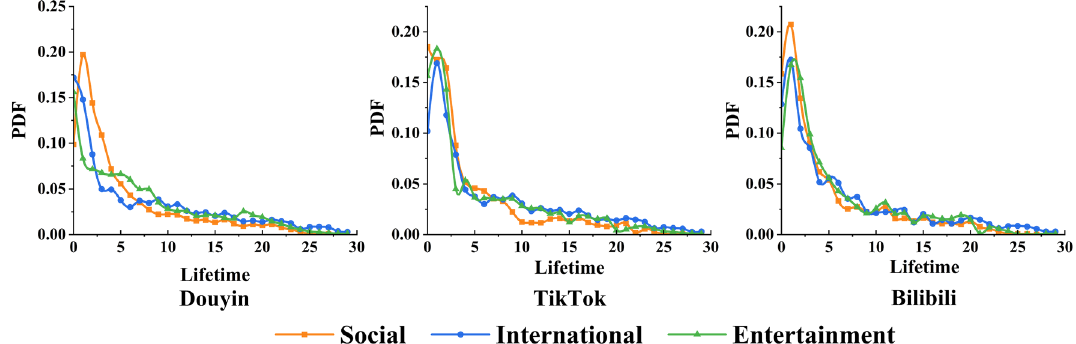
Figure 7. PDF of short video ECs’ lifetime. We calculated the lifetime as the length of time between the first user and the last user comment within the same short video. The probability density function (PDF) of the lifetime of a short video is in days as a time